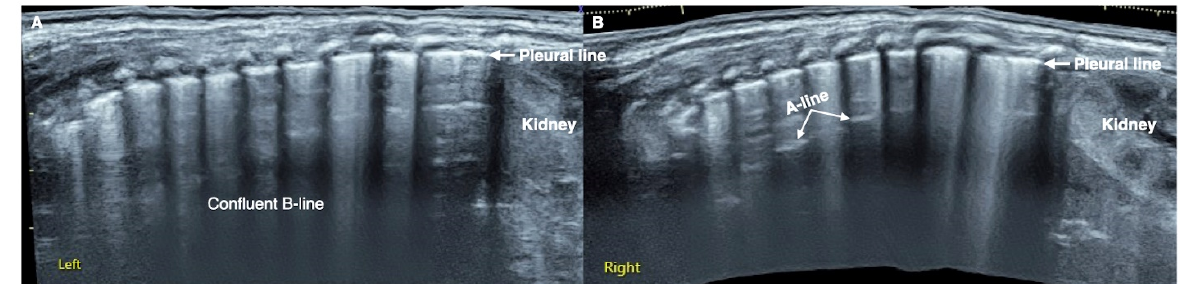
Figure 4. The convalescent ultrasound findings of this L. pneumoniae. LUS (extended view) showed significant confluent B-lines in both lung fields (( A ): left lung, ( B ): right lung), the pleural line is rough and fuzzy, A-line is present only in a few intercostal spaces of the right lung ( B ). Lung consolidation and atelectasis disappeared in the whole lung fields. It is suggested that there is obvious pulmonary edema in the infant’s lungs.